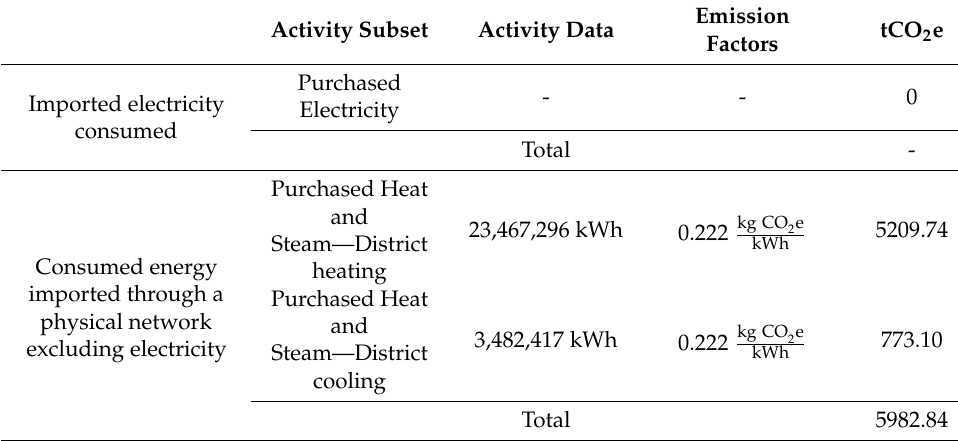
Table 5. Emissions from GHG categories of Scope